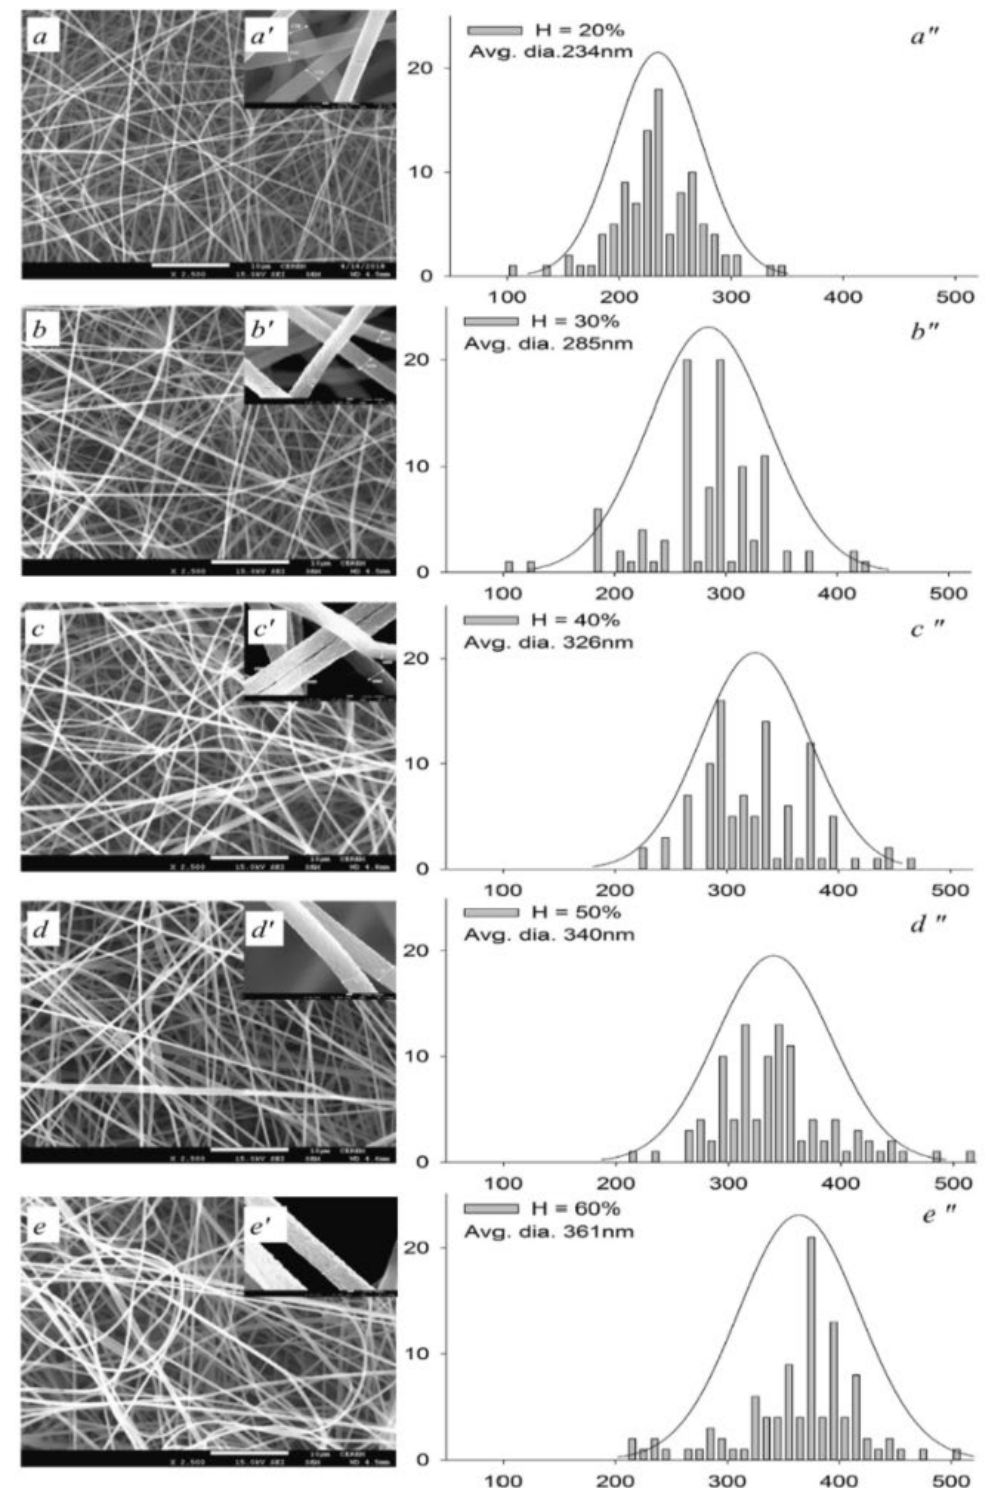
Figure 3. The effect of the distance from the tip to the collector on the ENM ( a – e ) at distances of 100 m m, 150 mm, 200 mm, 250 mm, and 300 m m, respectively. The bar scale in ( a – e ) is 10 µ m and in ( a ′ – e ′ ) is 100 nm. Reprinted with permission from ref. [40] . Copyright 2019 Elsevier. ( a ′ – e ′ ) is 100 nm. Reprinted with permission from ref. [40]. Copyright 2019